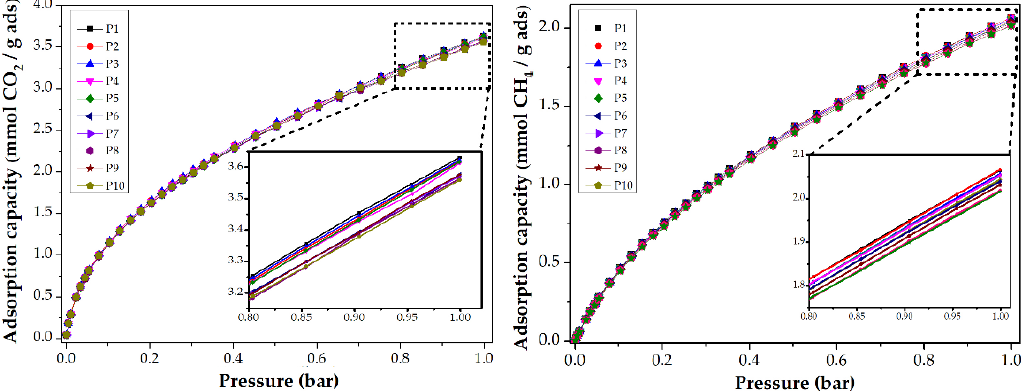
Figure 6. CO 2 and CH 4 adsorption isotherms at 0 and 25 °C, respectively, of PANMF stabilized at 280 °C and carbonized at 900 °C: Evaluation of reusability.